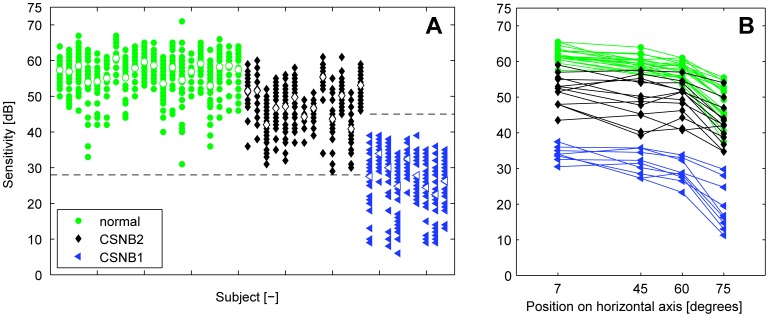
Scotopic visual field results of the normal subjects, the CSNB2 patients, and the CSNB1 patients.A: The threshold found at each location of the scotopic visual field, plotted per subject. The open markers represent the average threshold found in that subject. The dashed lines indicate the measuring range, which was 28 to 75 dB in control subjects and CSNB2 patients, and 0 to 47 dB in CSNB1 patients. We found slightly elevated thresholds in CSNB2 patients compared to the thresholds of normal subjects. The thresholds were more elevated in the CSNB1 patients. B: The averaged thresholds of four locations at 7°, 45°, 60° and 75° on the horizontal axes per subject. Thresholds were slightly elevated towards the far end of the visual field in control subjects. We found an equal decline in the control subjects, the CSNB2 and the CSNB1 patients.